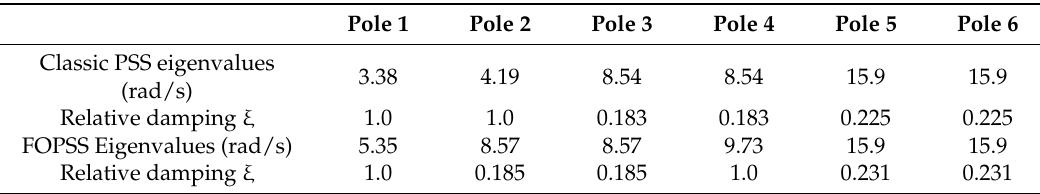
Table 5. Eigenvalues of the nominal closed-loop system poles